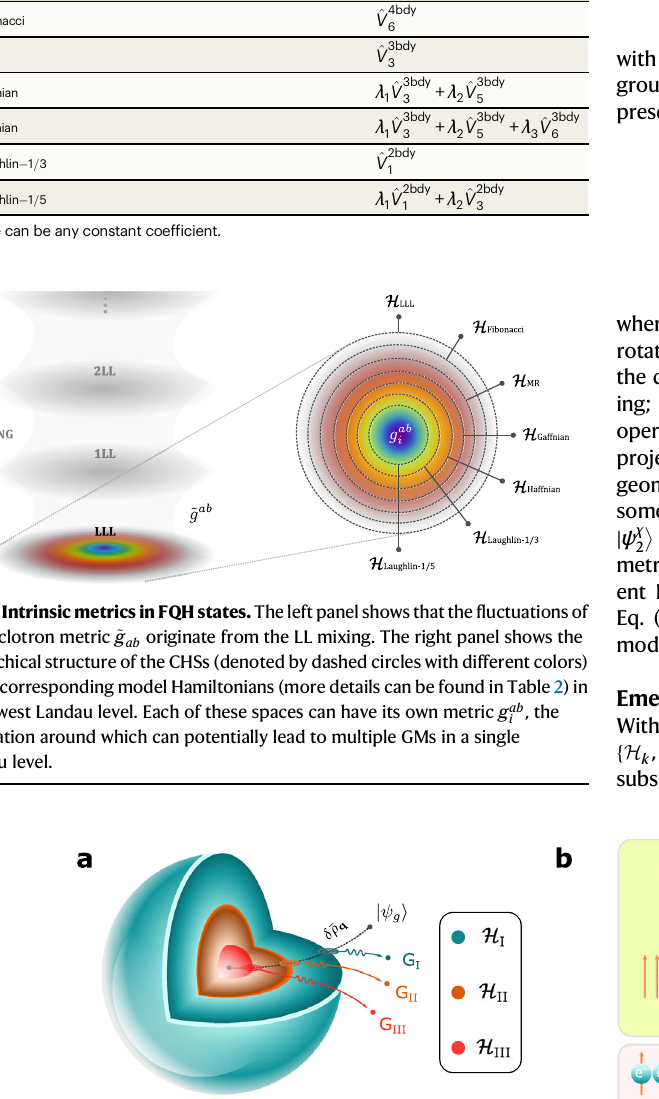
(cid:3) within H III (red